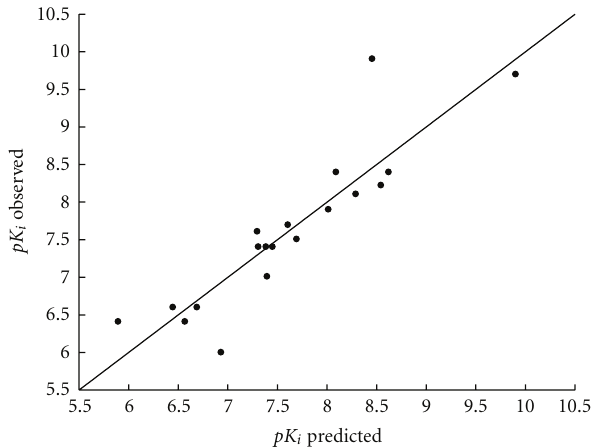
Figure 1: Observed versus predicted values of serotoninergic binding a ffi nity p K i according to (5).